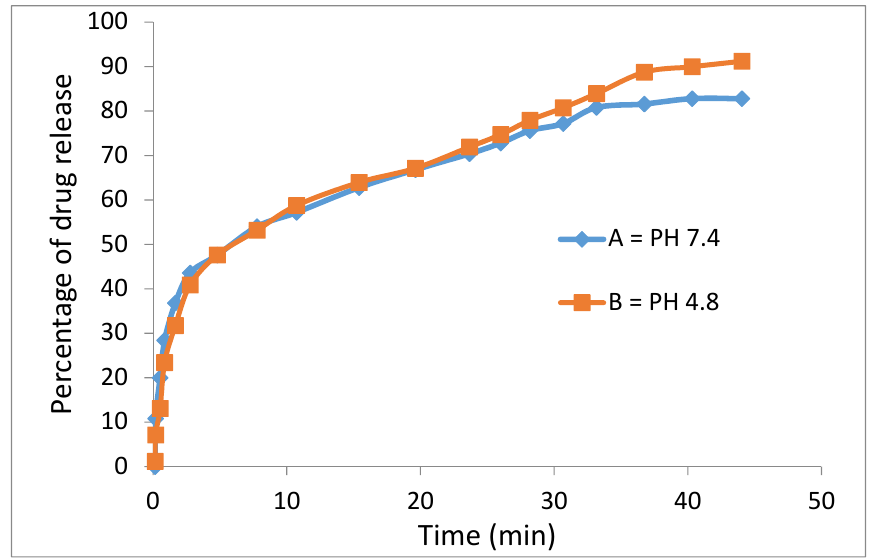
Figure 10. Release profiles of sorafenib from its physical mixtures in ( A ) M-PEG–SO–ZLDH in phosphate-buffered solution at pH 7.4; ( B ) M-PEG–SO–ZLDH in phosphate-buffered solution at pH 4.8 .